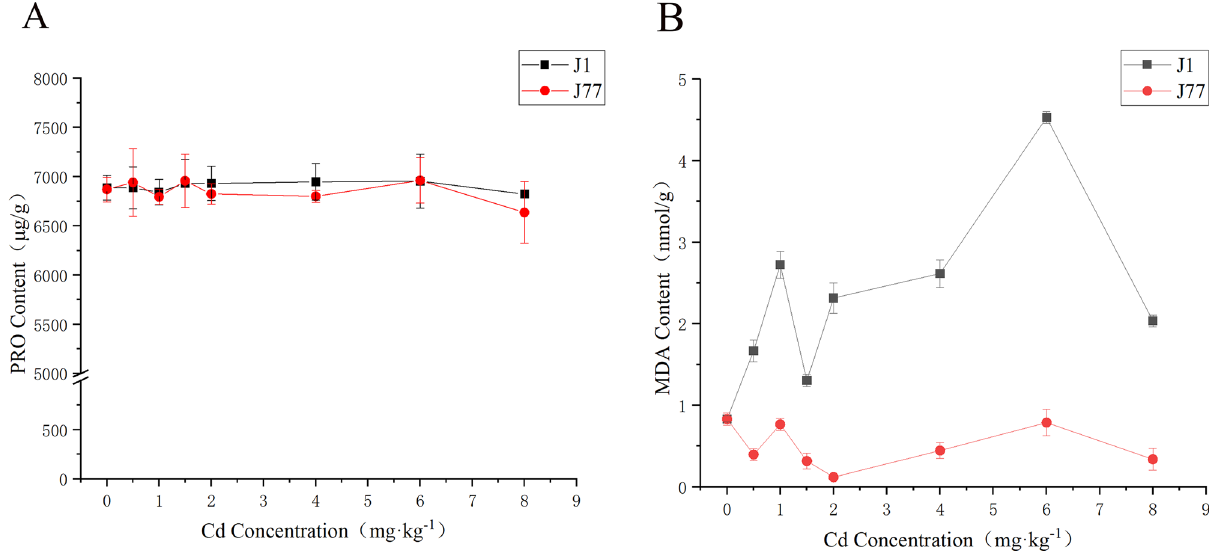
Figure 4. Effect of Cd stress on PRO and MDA content in fruiting